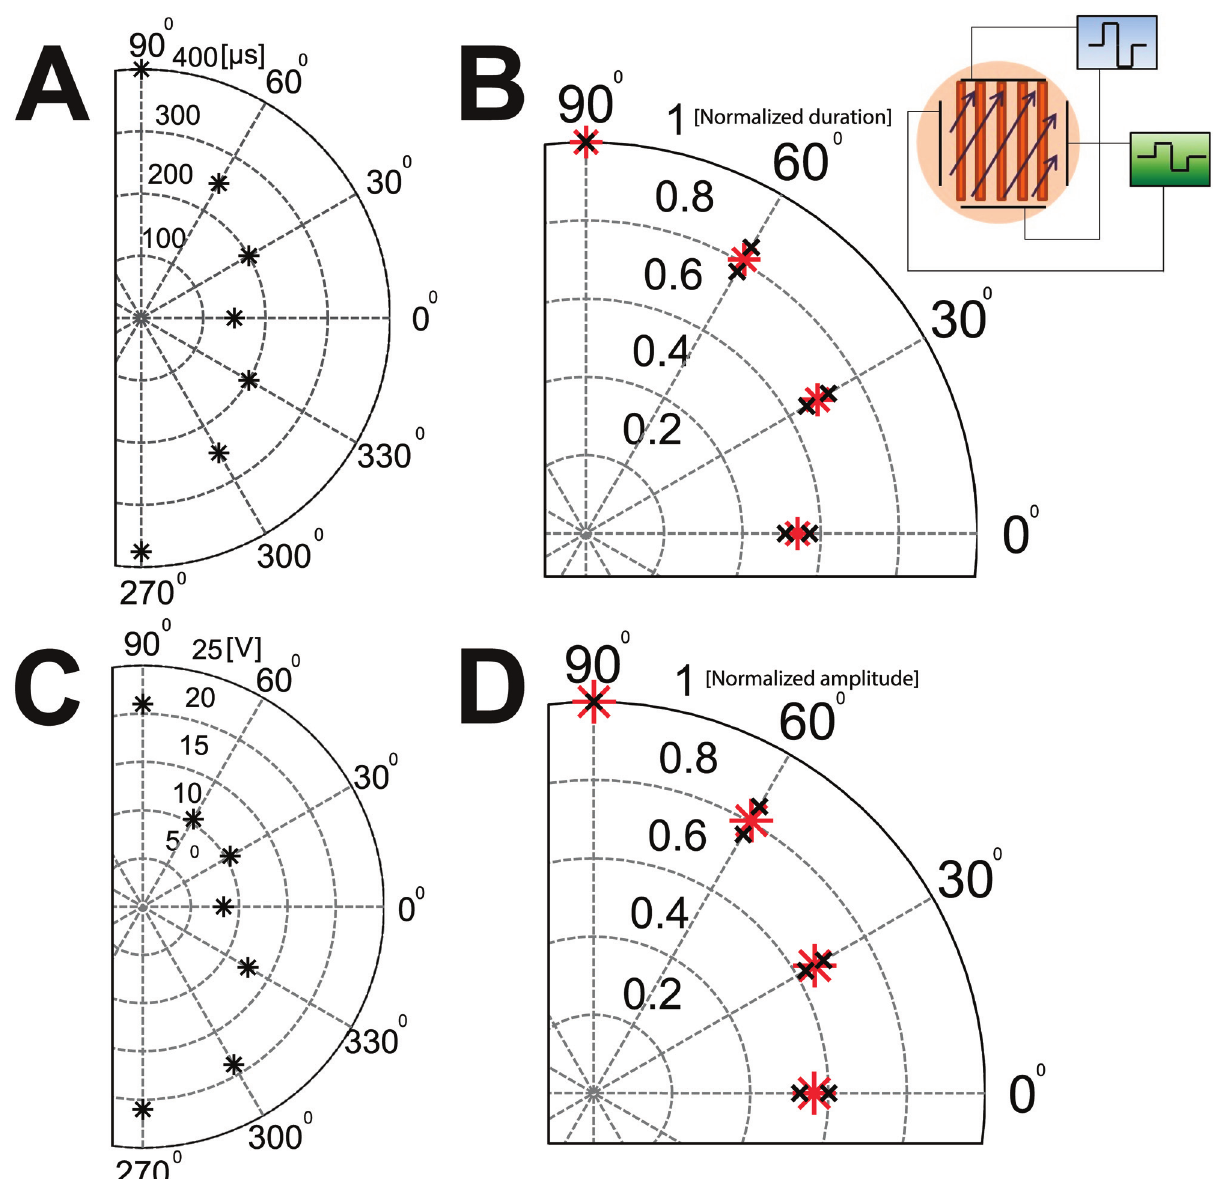
Fig 4. Angular dependence of minimal durations and amplitudes needed for exciting a connected 1D culture with varying angles with respect to the linear culture. (A) A typical example of an experiment with constant amplitude ( ± 22 V) and varying pulse durations. The pulse duration is represented by the distance from the center of the circle. In this example a square pulse of 400 μ s was needed to excite with the field perpendicular to the lines (90°), while only 150 μ s was needed for excitation parallel to the lines (0°). (B) Fixed amplitude results averaged over 15 different cultures. To allow averaging, the pulse duration in each experiment is normalized by the duration needed to excite the culture in 90 degrees and is plotted as the distance from the center. The red star represents the average, and the black crosses the standard error. The angles are “ folded ” to the first quadrant (e.g. 330° ! 30°). (C) A typical example of an experiment with pulse duration held fixed while the amplitude is varied. The distance from the center of the circle is now the amplitude of the square pulse (in Volts) needed for excitation of the culture. The duration was held constant throughout each experiment and was determined as the minimal duration needed for the excitation at ± 22 V for 90° orientation. (D) Average over 5 different cultures. The red star represents the average, and the black crosses the standard error. The amplitude of each experiment is normalized by the amplitude needed for excitation at 90°. Inset: Schematic for the setup with 1D networks. The 1D culture is grown on thin lines (width 170 μ m, length 11 mm). An external voltage is applied by two perpendicular pairs of bath electrodes, driven by two separate power supplies. The ratio between the amplitude of each pair of electrodes determines the angle of the electrical field allowing measurement of different angles without the need to manually rotate the